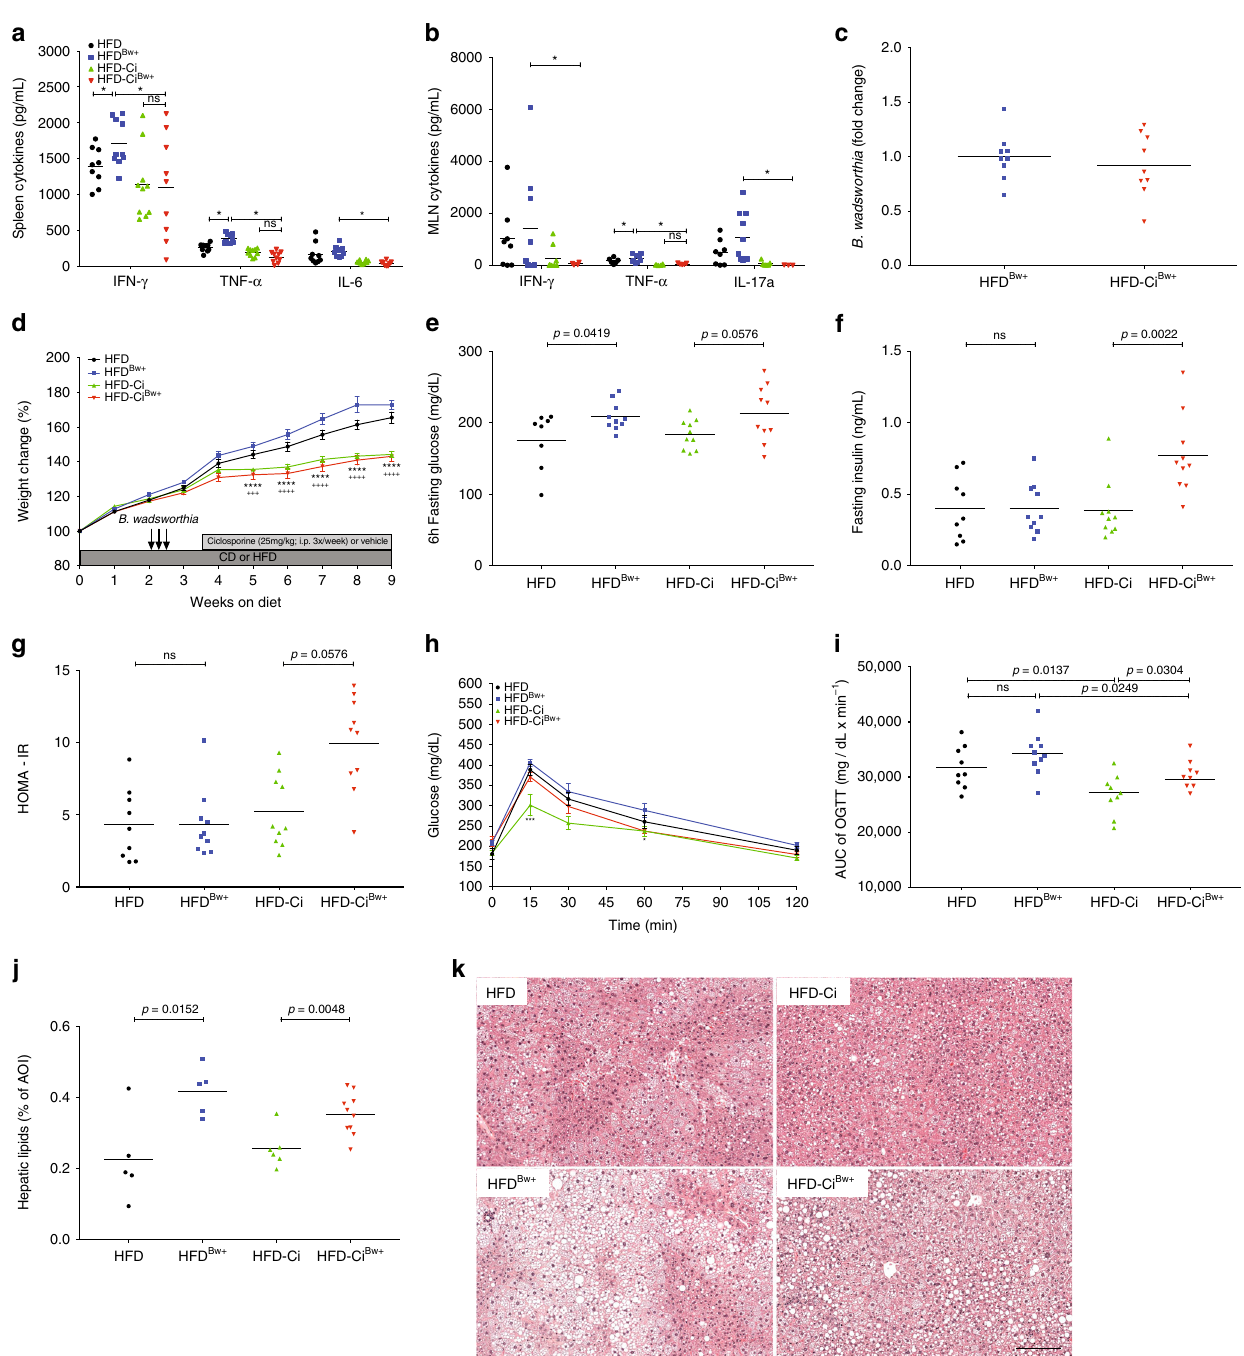
Fig. 8 Suppression of in fl ammation unmasks intrinsic effects of B. wadworthia on glucose homeostasis. Cytokine production in a spleen and b MLN of HFD fed mice receiving ciclosporine (Ci) and/or B. wadsworthia (Bw + ) (* p < 0.05, n = 8 – 10/group). c B. wadsworthia load in the caecum (* p < 0.05, n = 8 – 10/ group). d Weight gain after 9 weeks of HFD (**** p < 0.0001 HFD vs. HFD-Ci; +++ p < 0.001, ++++ p < 0.0001 HFD Bw + vs. HFD-Ci Bw + , n = 8 – 10/group). e Blood glucose, f insulin, g homeostatic model assessment-insulin resistance (HOMA-IR) after 5 – 6 h of fasting. h Blood glucose level before and after oral glucose tolerance challenge (OGTT; 2 g/kg mouse; *** p < 0.001, * p < 0.05 HFD-Ci vs. HFD-Ci Bw + ; n = 8 – 10/group). i Area under the curve (AUC) of OGTT. j Lipid area, calculated as % area of interest (AOI), in liver cross-sections stained with H&E. k Representative pictures of liver stained with H&E. Scale bar = 100 µ m. Statistical comparison was performed by fi rst testing normality using Kolmogorov – Smirnov test and then ANOVA or Kruskal – Wallis test with Bonferroni or Dunn ’ s post hoc test. Error bars represents